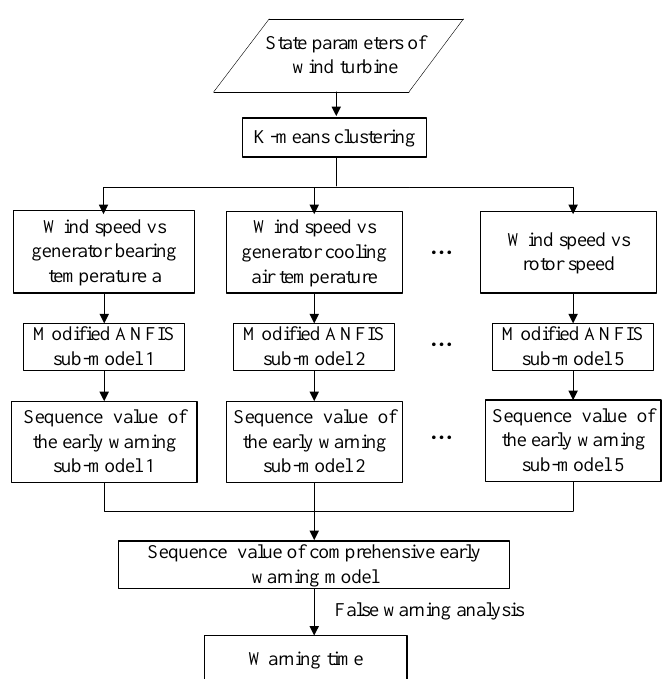
Figure 5. Case implementation flow chart. Energies 2017 , 10 , 898